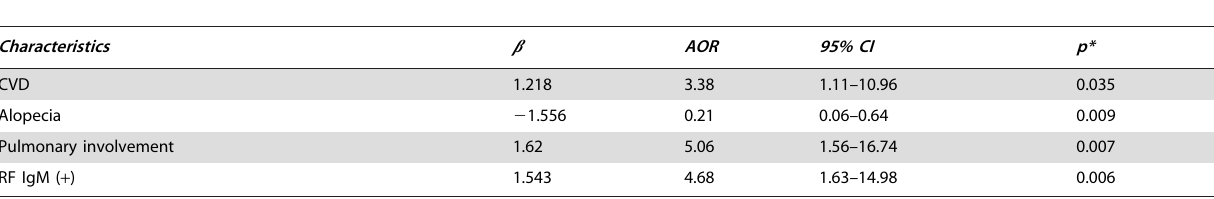
Table 3. Adjusted factors associated with APS in SLE polyautoimmunity (multivariate analysis).